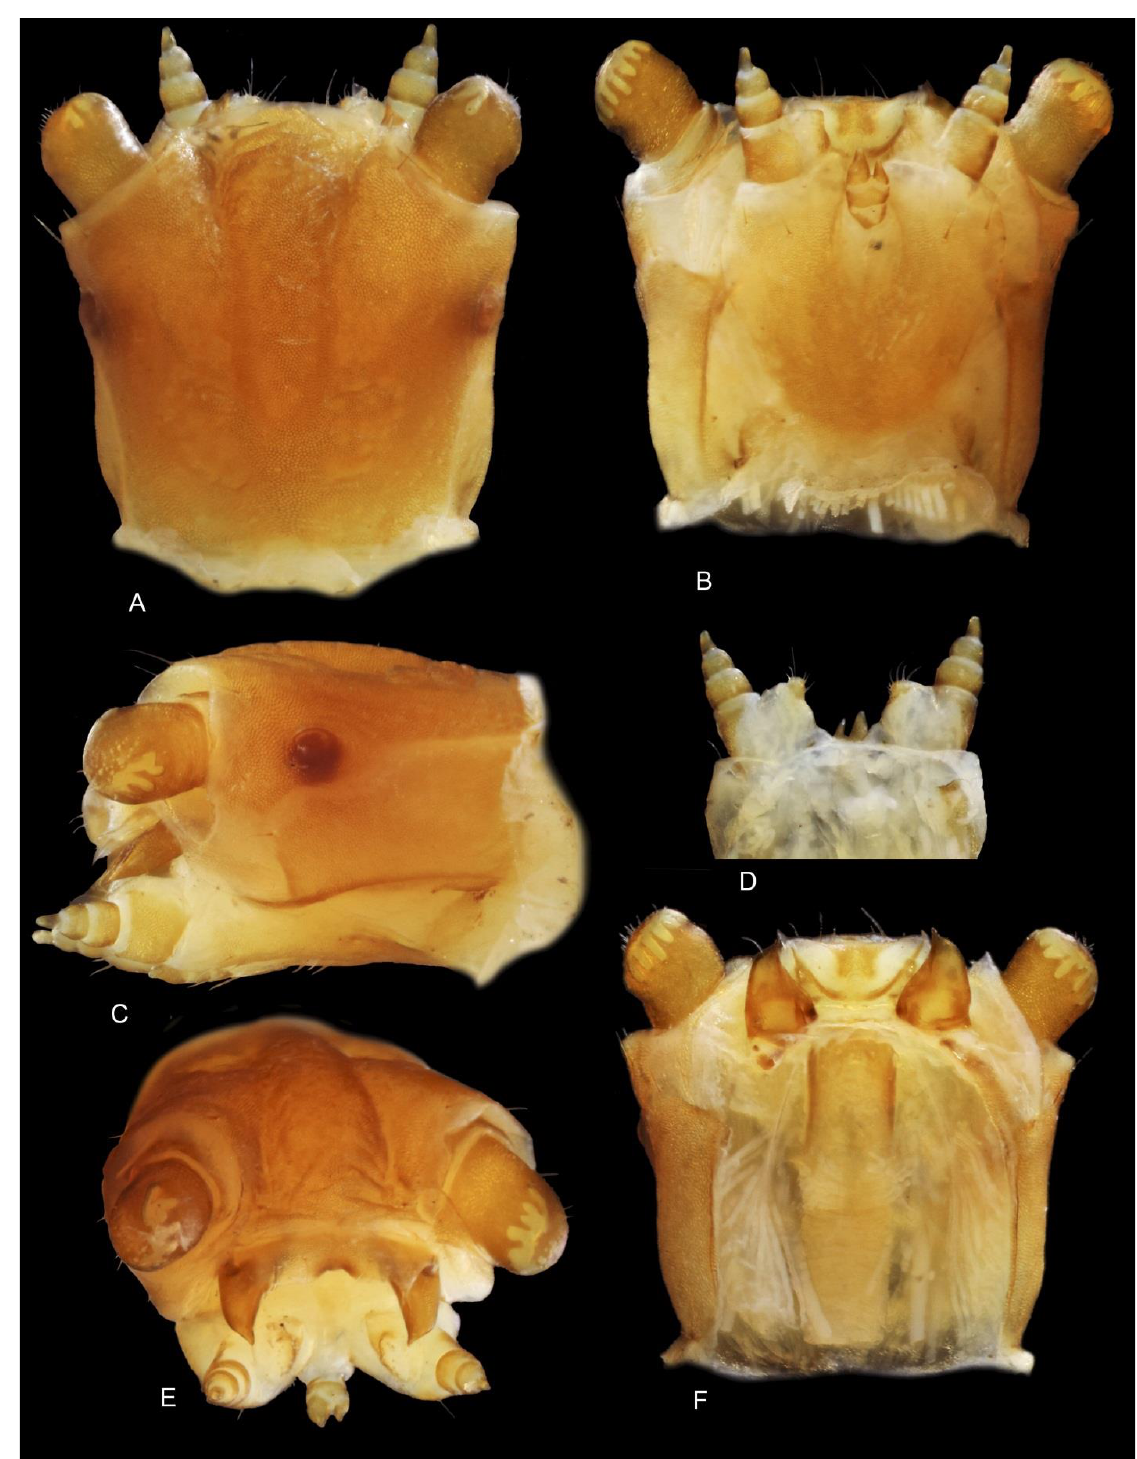
Figure 6. Platerodrilus svetae , female. ( A ) — head, dorsally; ( B ) — same, ventrally; ( C ) — same, laterally; ( D ) — maxillae; ( E ) — head, frontally; ( F ) — head, labio-maxillar complex removed, ventrally.